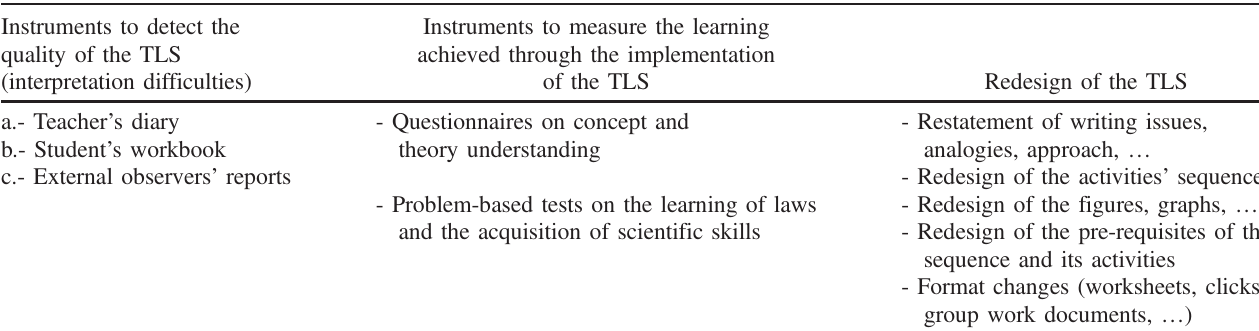
TABLE IV. Instruments for the iterative development of the TLS. Instruments to detect the quality of the